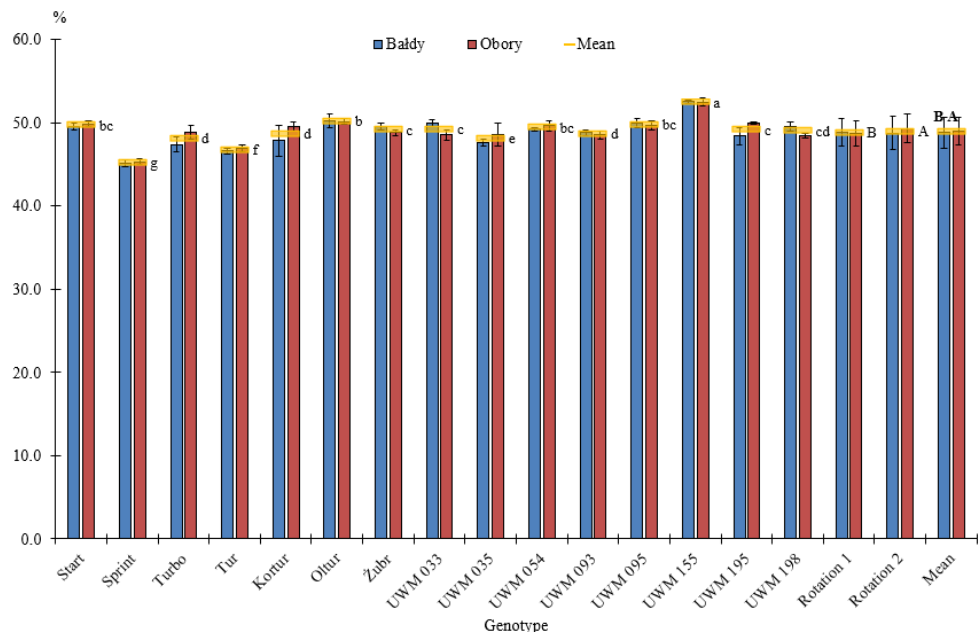
Figure 1. Moisture content in the biomass of 15 willow genotypes obtained at two locations in two consecutive three-year harvest rotations; (error bars determine standard deviation; lower case letters a,b,c... denote homogeneous sets in Tukey’s test for mean values calculated for genotypes regardless of the location; capital letters A,B denote homogeneous sets for mean values calculated for the harvest rotation; bold capital letters A,B denote homogeneous sets for mean values calculated for the habitats; ns denotes insignificant differences).